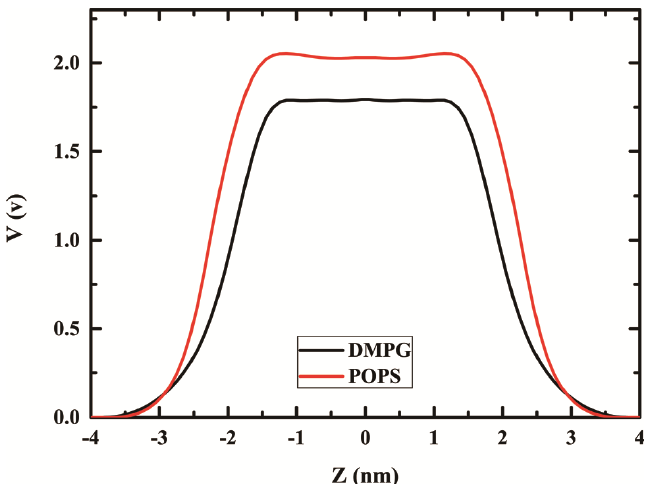
Figure 9. The electrostatic potential for membrane bilayer.